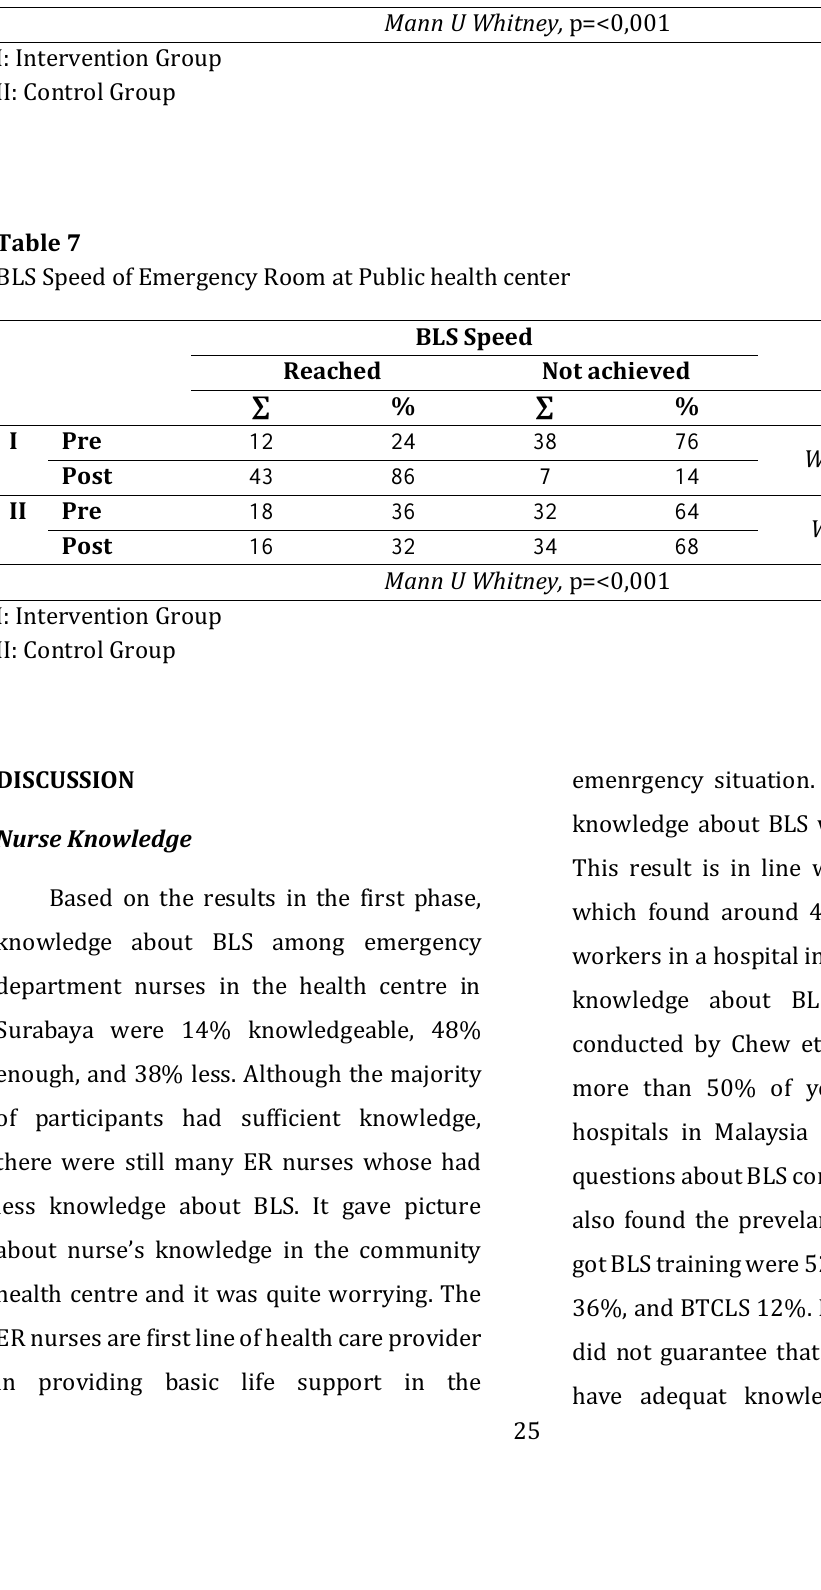
BLS Accuracy Skilled